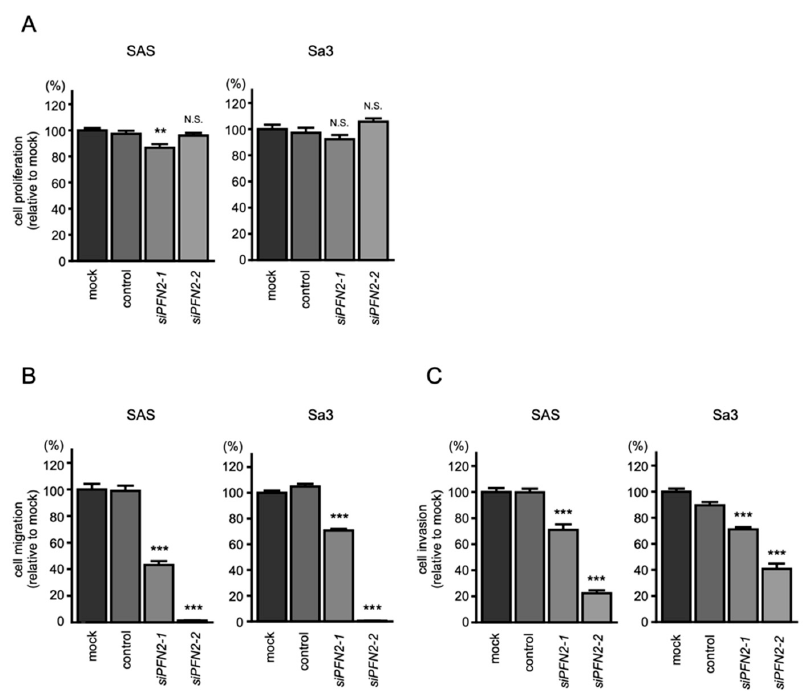
Figure 9. Functional assays after knockdown of PFN2 in HNSCC cell lines (SAS and Sa3): ( A ) cell proliferation assays; ( B ) cell migration assays; ( C ) cell invasion assays. (** p < 0.01, *** p < 0.001, N.S.: not significant).